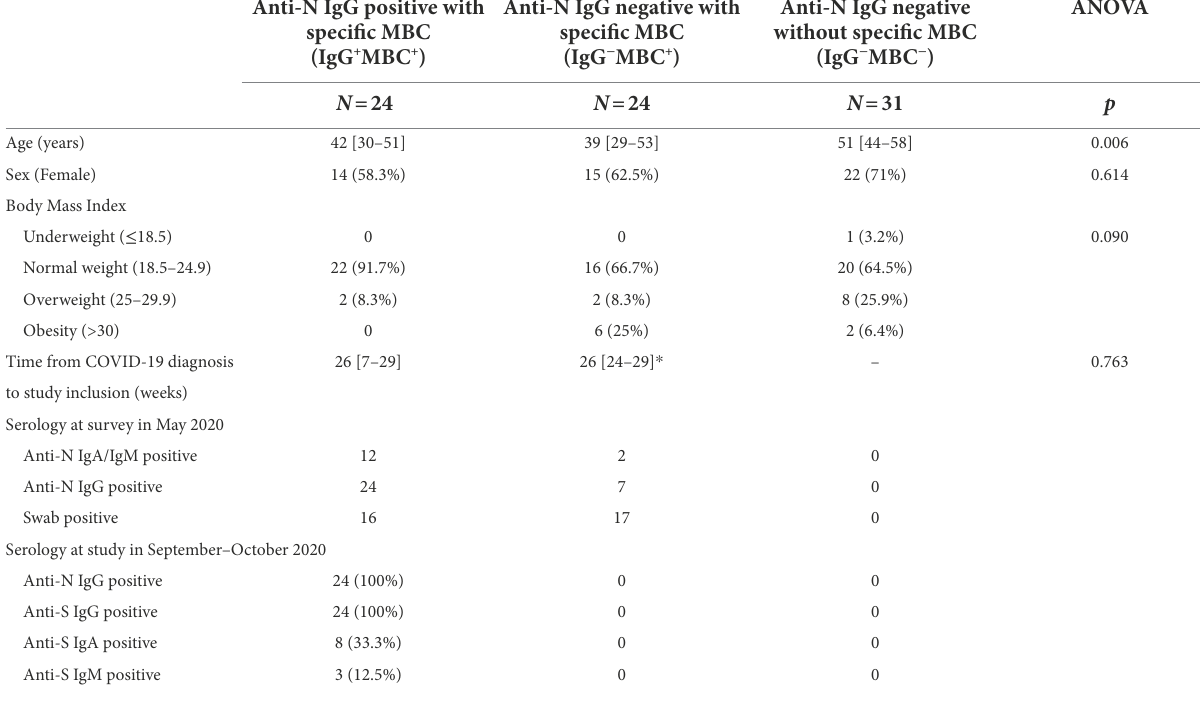
TABLE 1 Characteristics of the individuals included in this